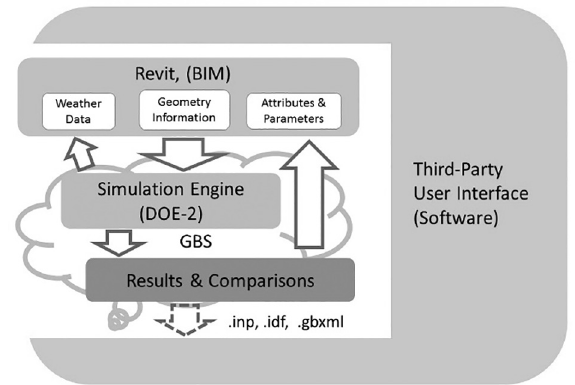
Figure 5. The architecture of Revit & Energy Analysis for Revit